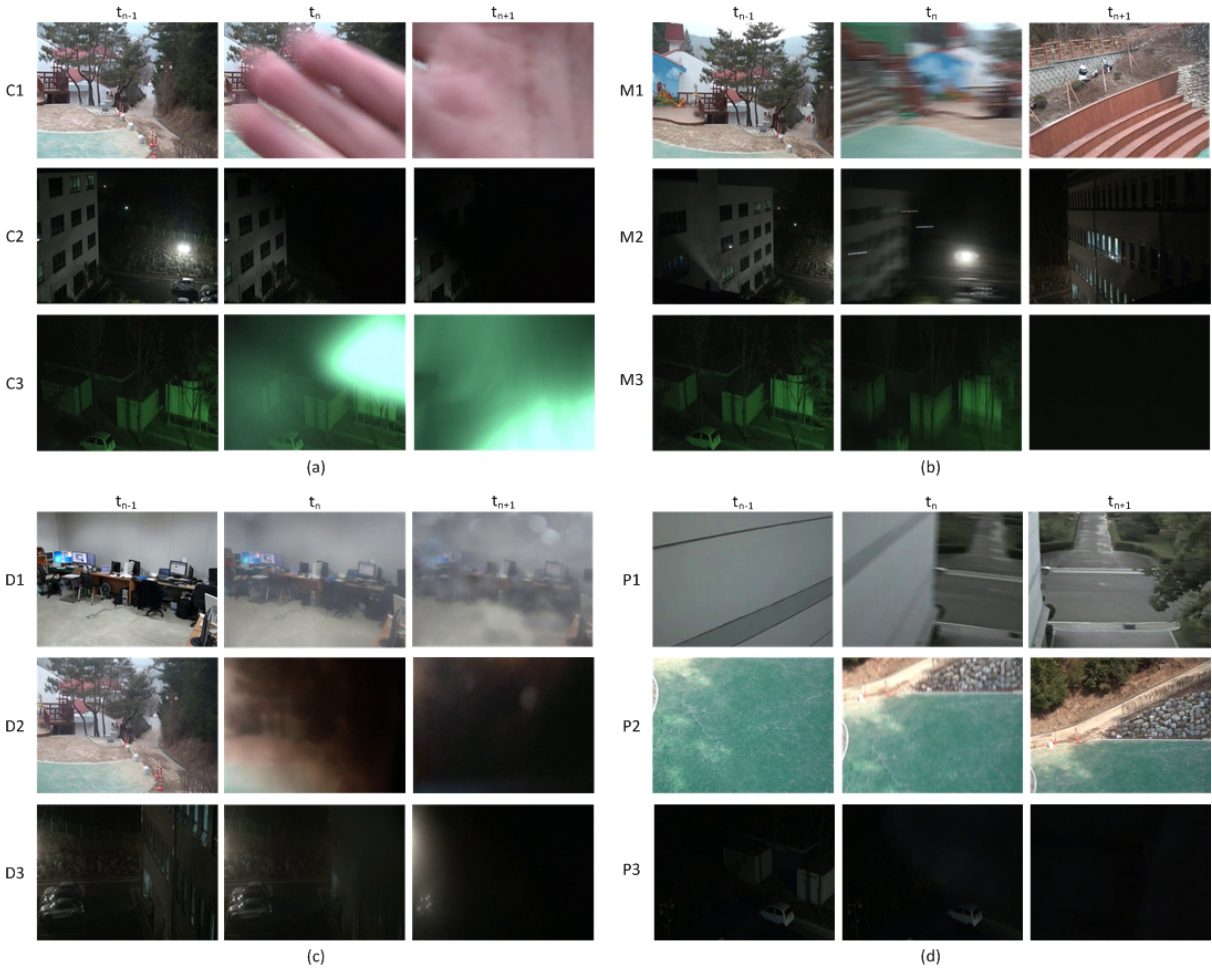
Figure 6. An example image for EDR calculation: ( a ) covered sequences; ( b ) moved sequences; ( c ) defocused sequences; ( d ) plain sequence (simple and plane background or very low